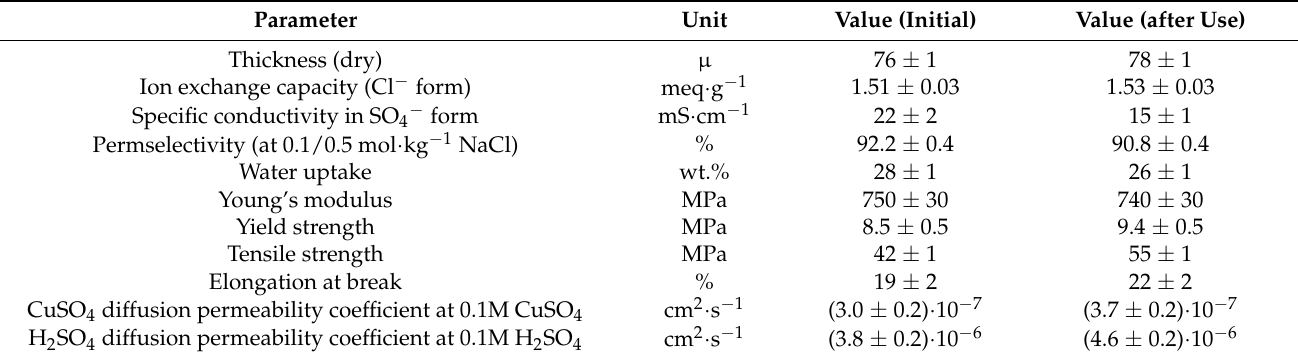
Table 7. Physical and chemical parameters of Fumasep ® FAD-75.